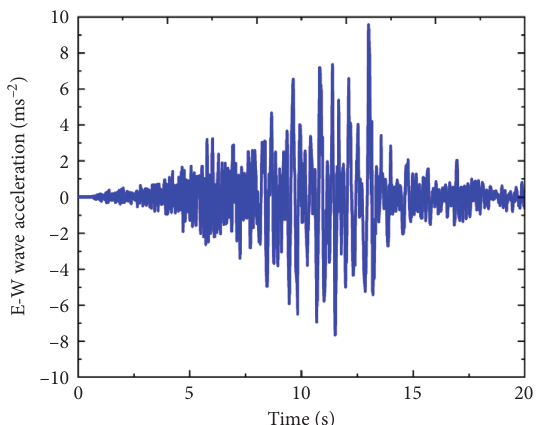
Figure 16: E-W wave acceleration-time history curve.